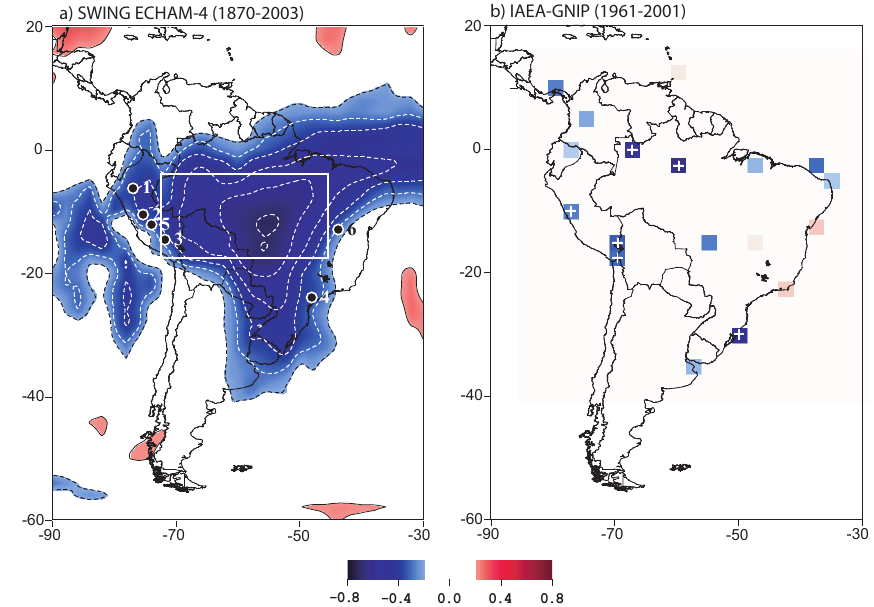
Fig. 4. (a) Spatial correlation of monsoon index M (DJF precipitation averaged within white box) with precipitation-weighted DJF δ 18 O values throughout the South American monsoon domain in SWING simulation with ECHAM-4 (1870–2003). Only regions with significant correlation at p < 0.05 are shaded. Contour intervals are 0.1, with − 0.1, 0 and 0.1 contour lines omitted. (b) as in (a) but based on IAEA- GNIP observations and ice core records from Huascar´an, Quelccaya and Sajama correlated with monsoon index based on vertical wind shear as defined in Vuille and Werner (2005). Record lengths of individual observations vary, but all records contain at least 10yr within period 1961–2001. Note that unlike in ( (a) all correlations are shown but that significant correlations at p < 0.05 are indicated with a white cross. Panel (b) is modified from Vuille and Werner